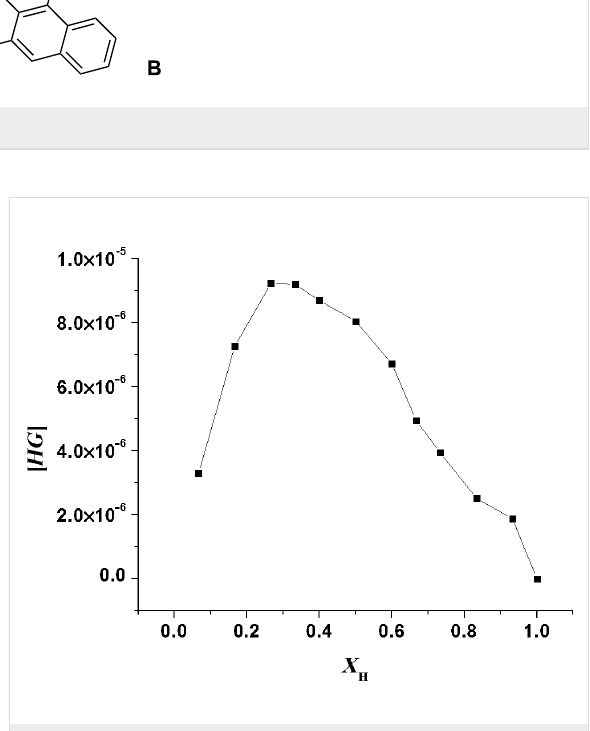
Figure 7: Fluorescence Job plot of 1 with H 2 PO 4 −